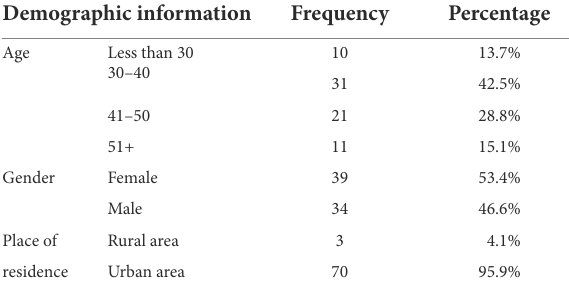
TABLE 1 Demographic information of